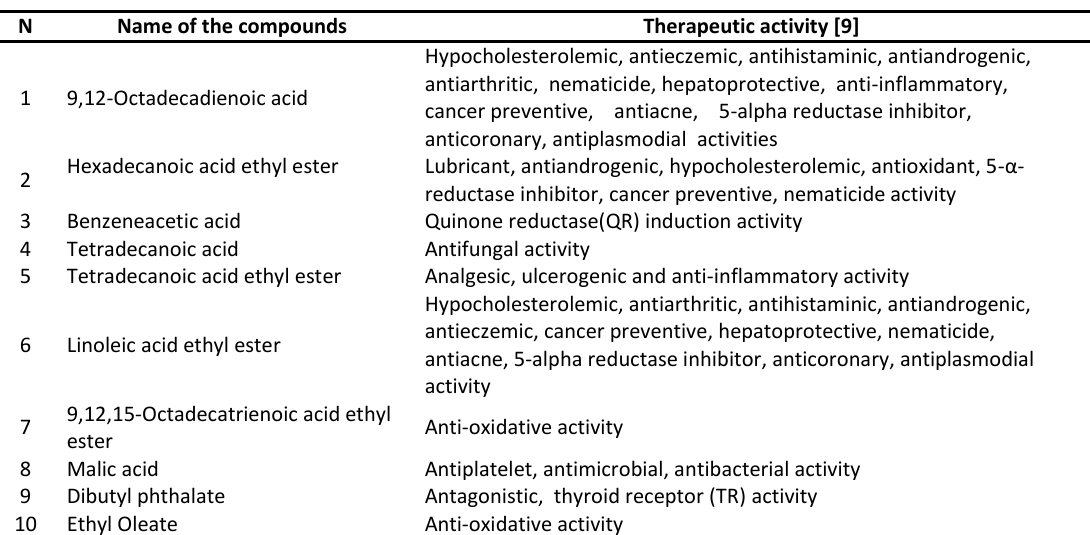
Table 3. Therapeutic activity of some fatty acids and their esters identified from the n -hexane and chloroform fractions of aerial parts and roots of Cicuta virosa